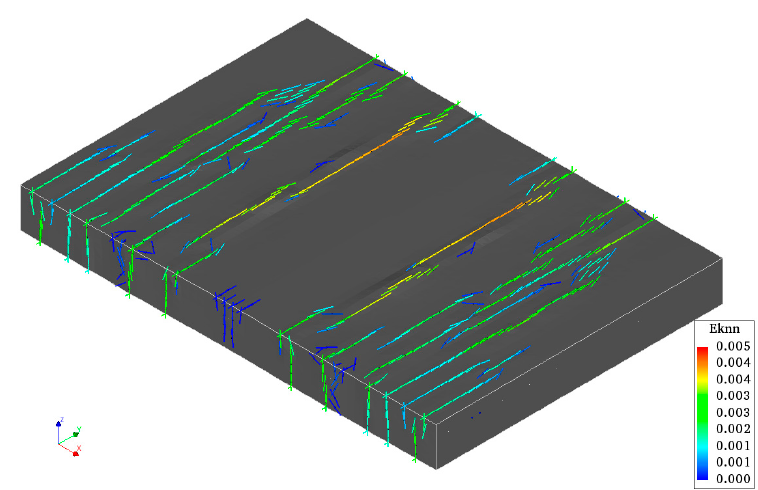
Figure 14. Development of the randomly occurring crack pattern in the CRCP segment without partial surface saw-cuts.